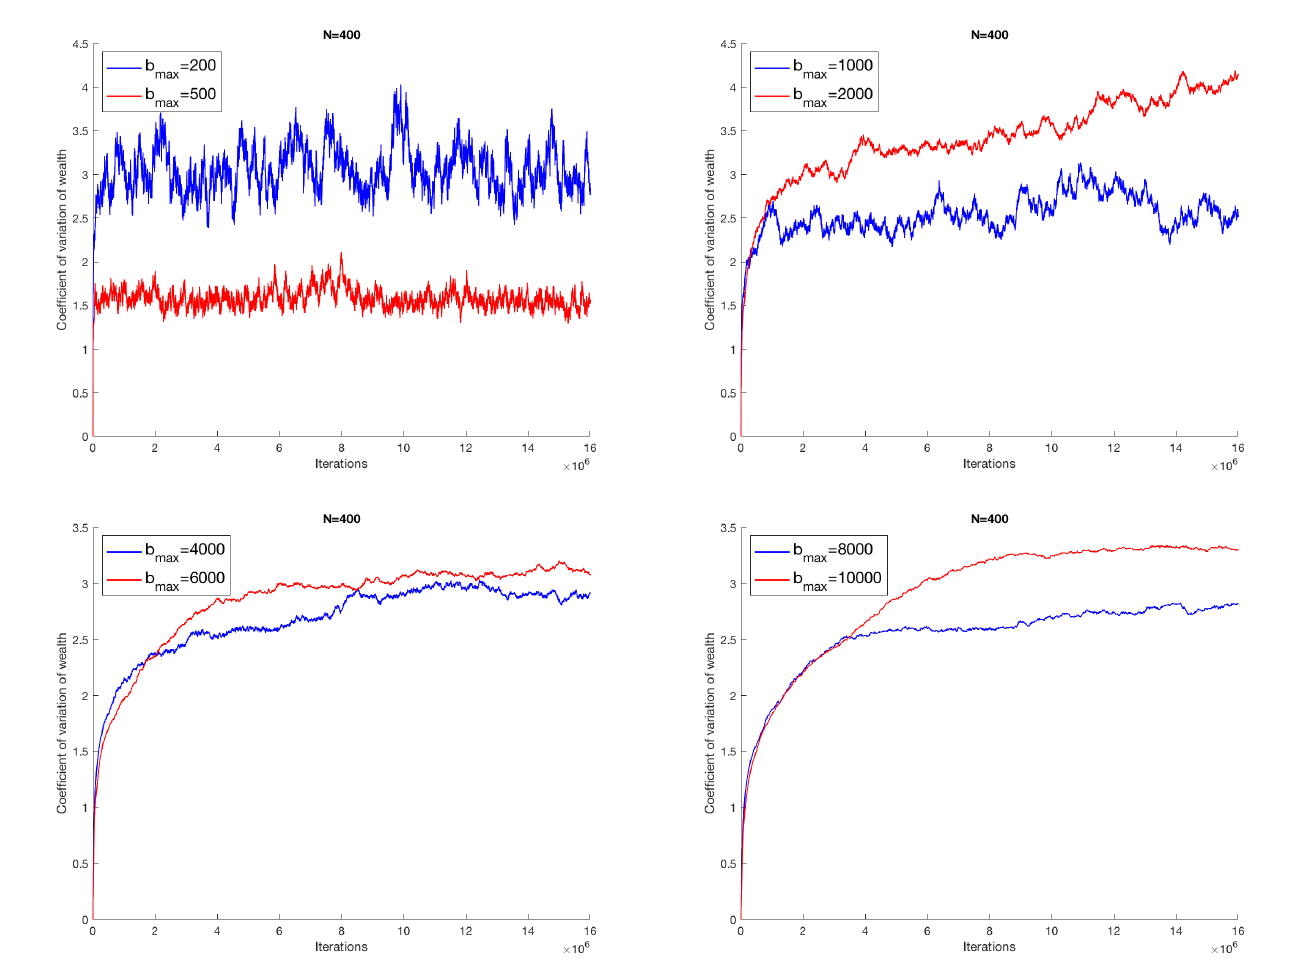
Figure 5. Plot of the coefficient of variation of the amount of money of the economic agents as transactions go on for N = 400 and b max = 200,500 ( top left ), b max = 1000,2000 ( top right ), b max = 4000,6000 ( bottom left ), b max = 8000, 10,000 ( bottom right ). The number of successful transactions is 100 N 2 . All agents enter the market with the same amount of money and the same money equivalent of